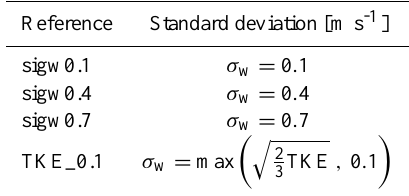
Table 2. Definitions of vertical velocity pdfs in HadGEM-UKCA